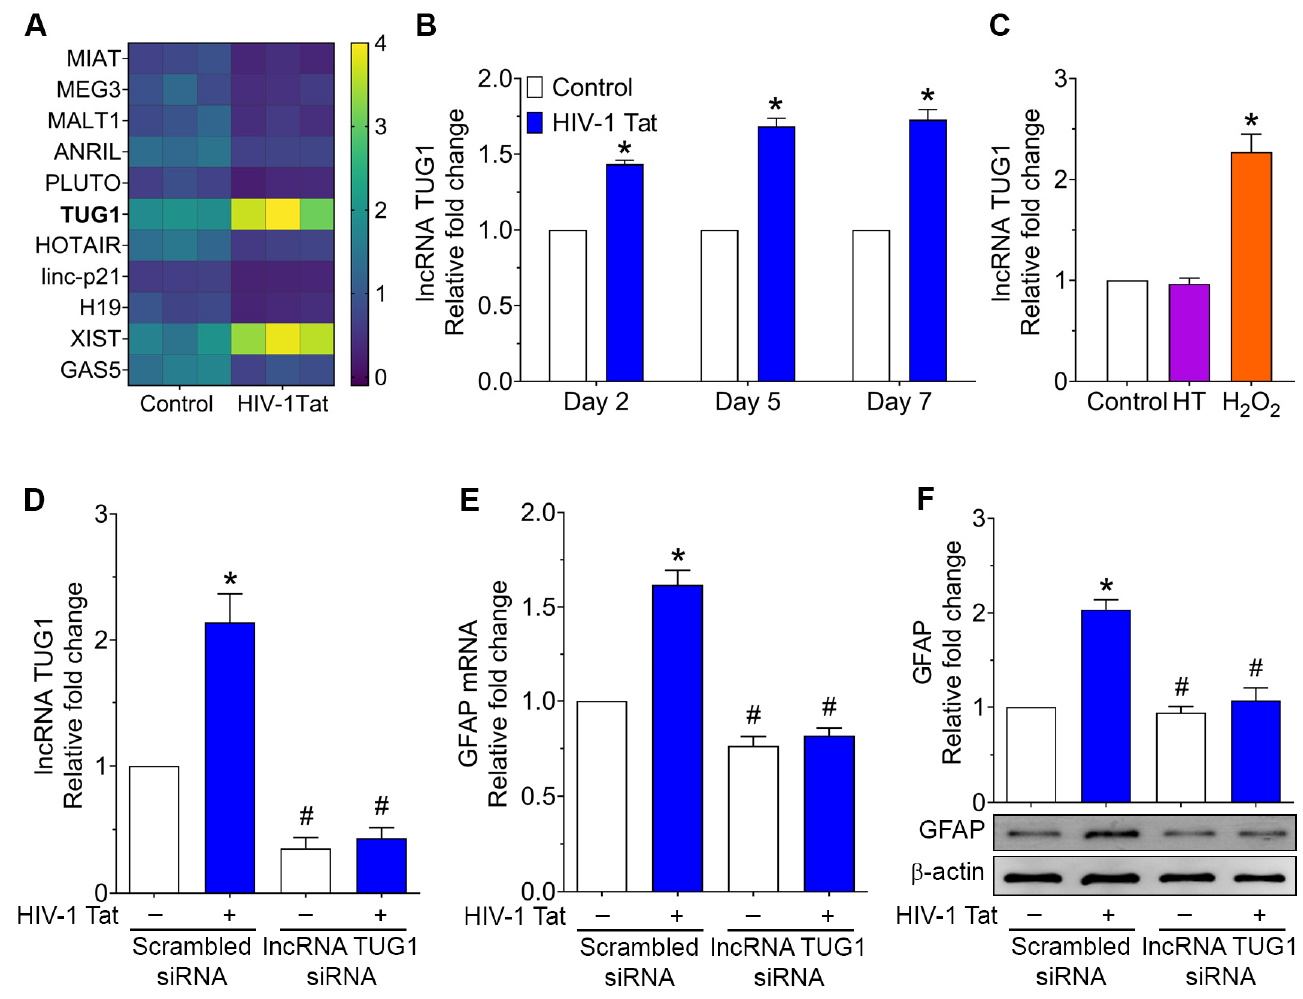
levels of the proinflammatory cytokines (Figure 3I–K) were also normalized in lncRNA TUG1-silenced, HIV-1 Tat-exposed HPAs.